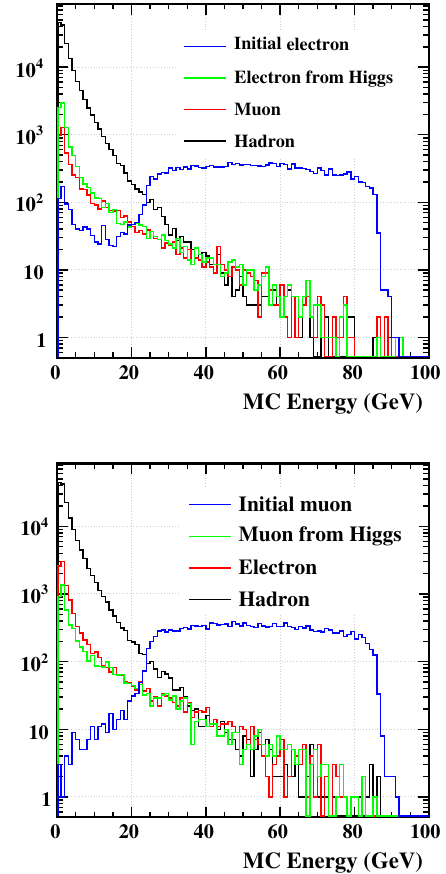
Fig. 10 EnergySpectrumofchargedparticlesineeHeventat250GeV center of mass